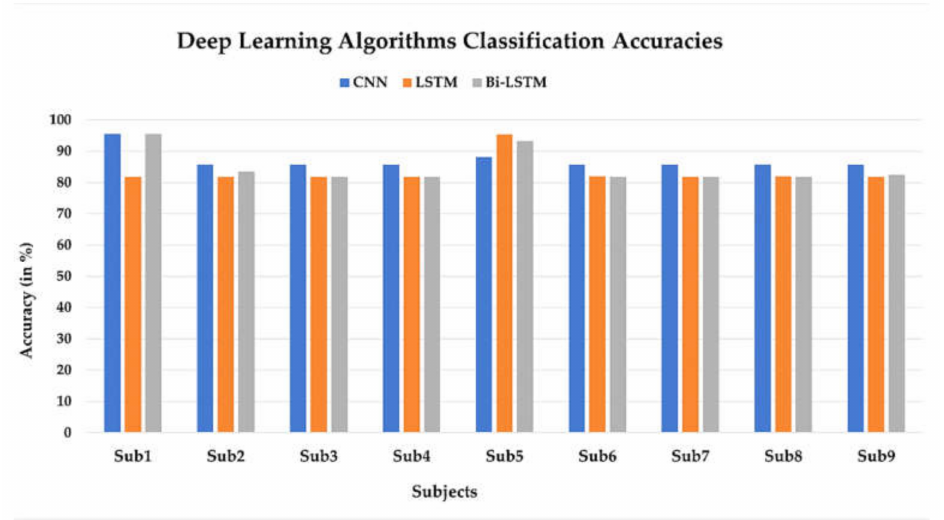
Figure 10. Deep-learning (DL) classifier accuracies (in %) for nine subjects. The DL classifiers are convolutional neural network (CNN), long short-term memory (LSTM), and bidirectional LSTM